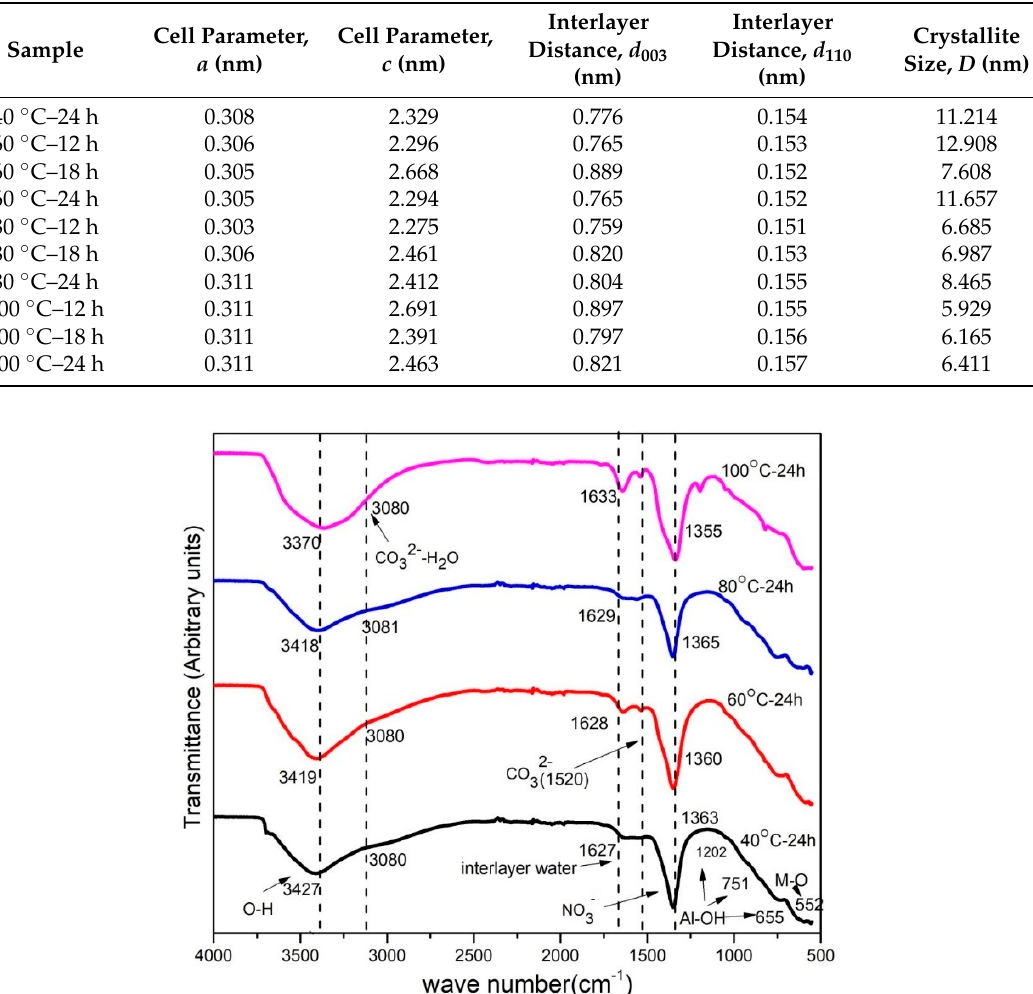
samples fabricated at different reaction temperatures.